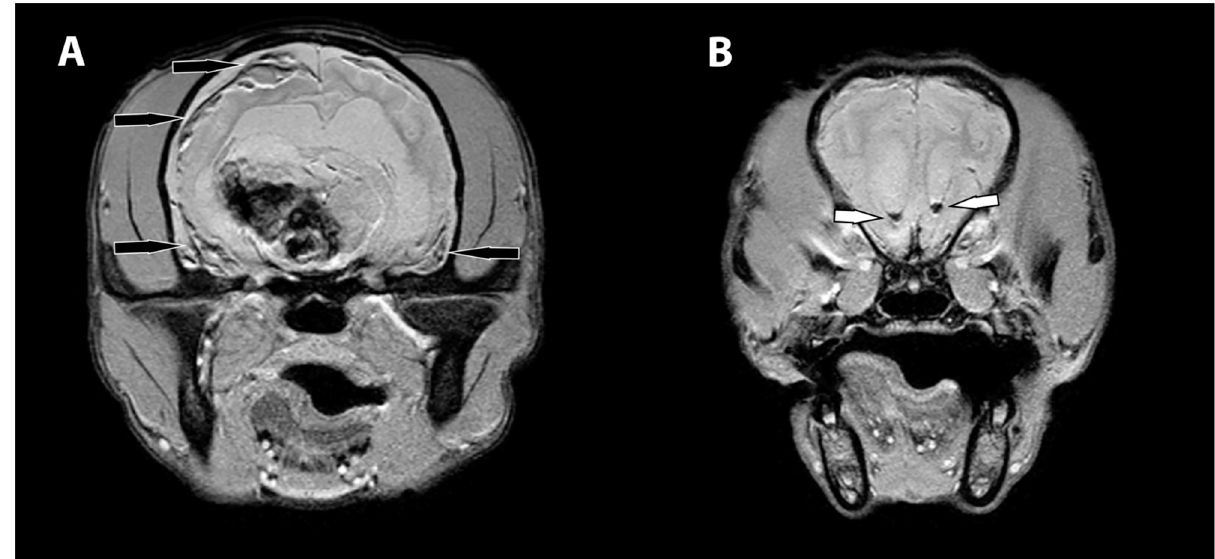
Figure 2. MRI images of the subdural and intraventricular hemorrhage. The transverse T2* weighted images ( A ) display heterogenous, mostly hypointense band of hemorrhage in the region of the subdural space, right worse than left (black arrows). More rostrally, the transverse T2* weighted images ( B ) show foci of signal void within the lateral ventricles, consistent with intraventricular hemorrhage (white arrows).